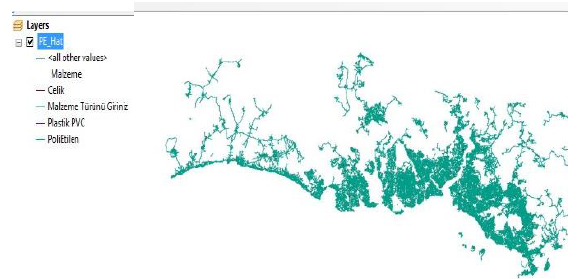
Figure 8. 2D utility layer in shapefile format.